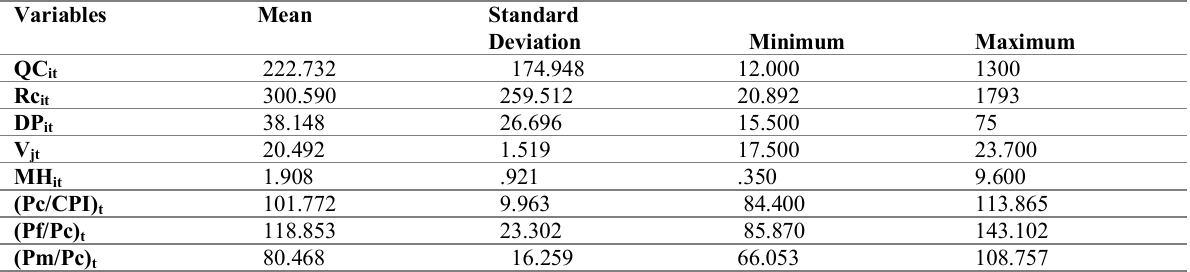
Table 4 : Statistical Description of Variables